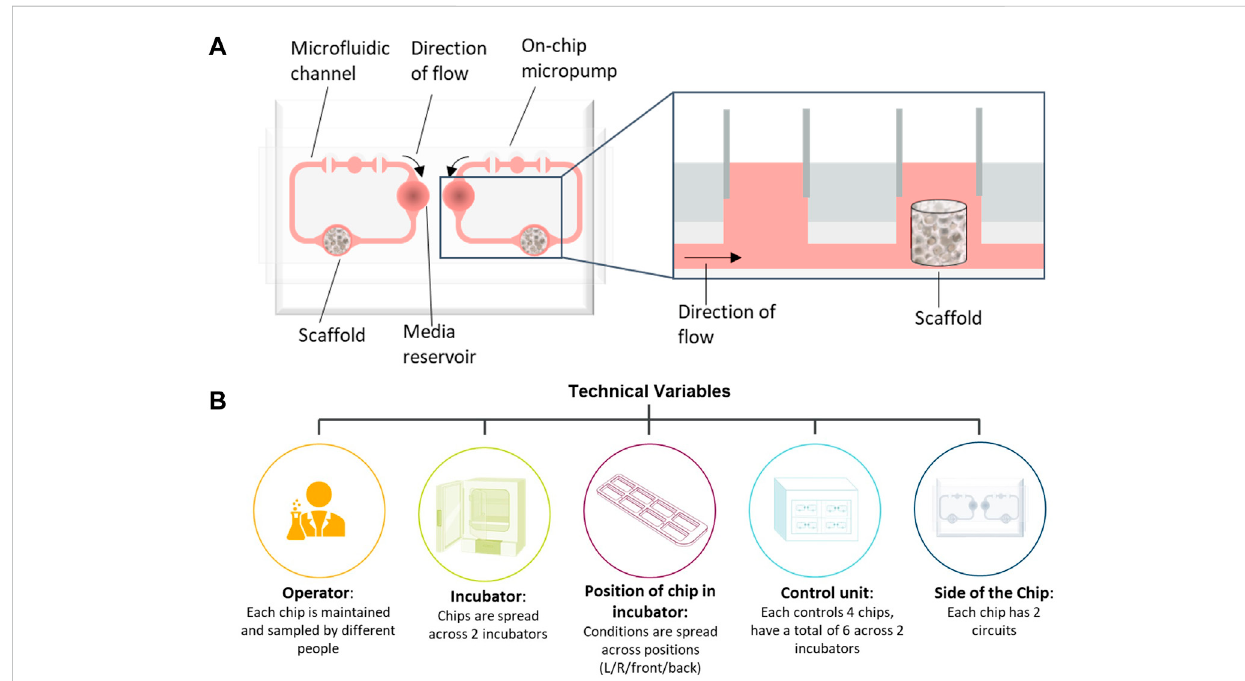
FIGURE 1 Bone marrow (BM) chip schematic and confounding factors. (A) Schematic of bone marrow microphysiological system (MPS) using the TissUse 2- Organ-Chip. (B) Schematic of possible confounding factors in the bone marrow MPS studies that have been accounted for in the study